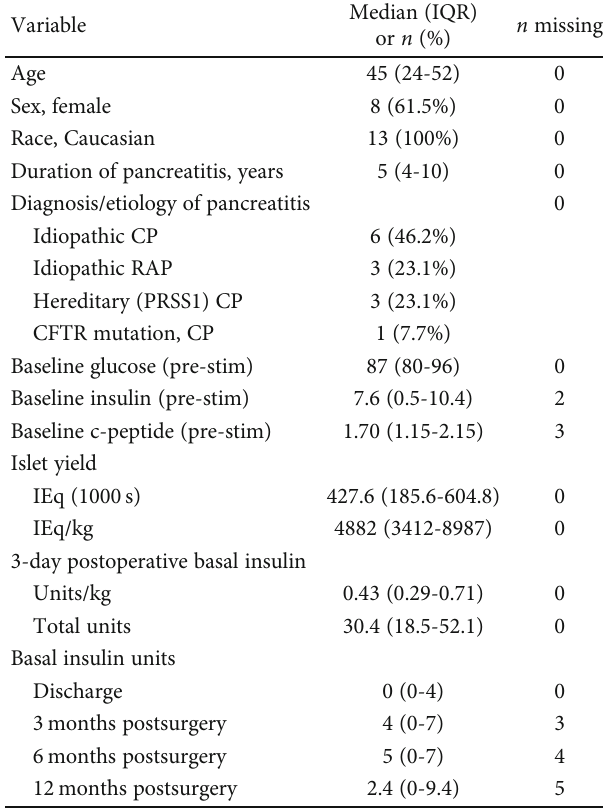
Table 1: Patient Characteristics, n = 13